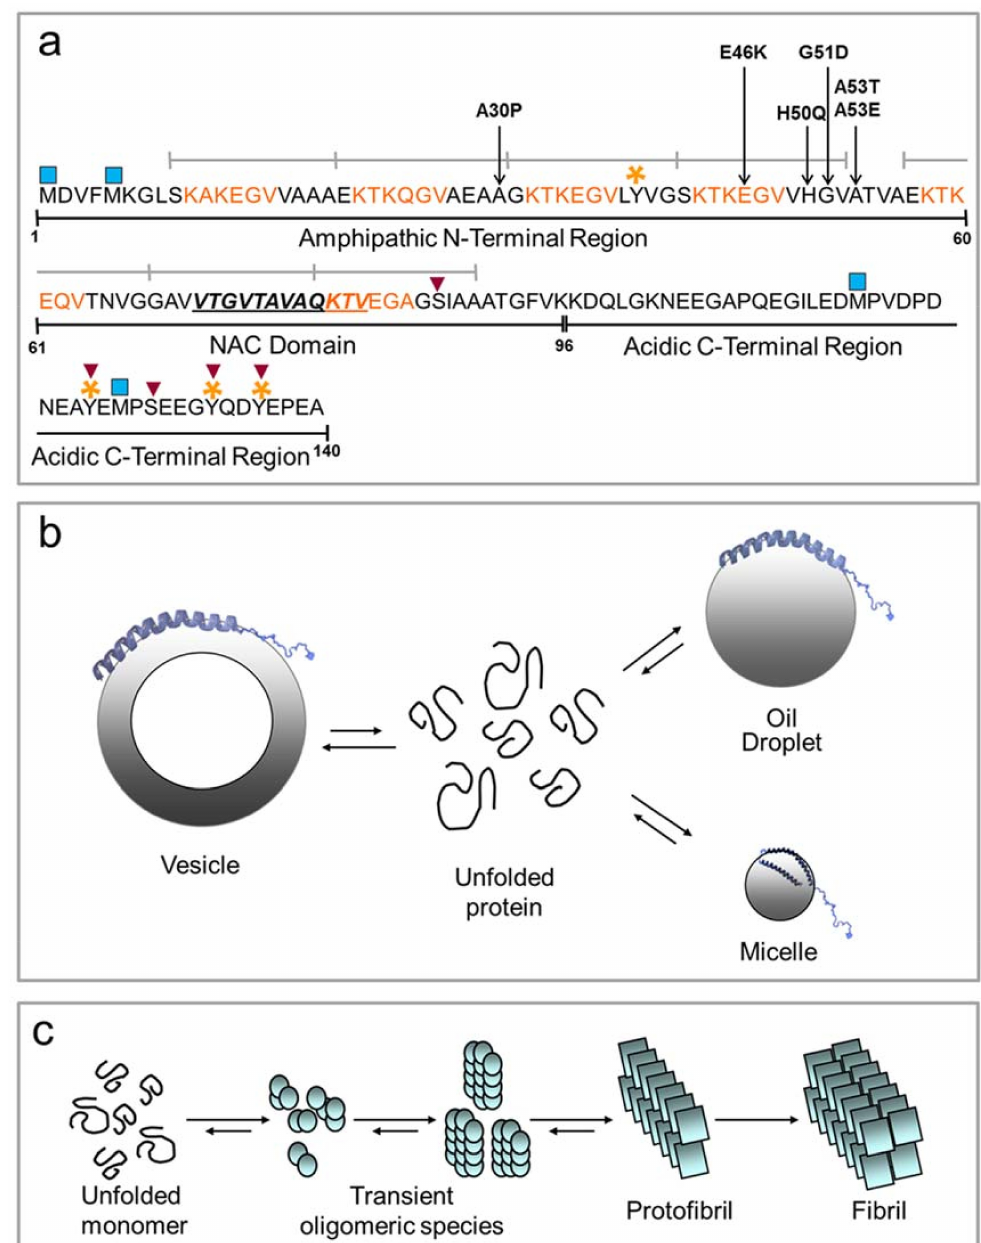
Figure 2. Scheme of the structure of α -syn. ( a ) The three major domains of the protein are indicated: the N-terminal region involved in lipid and membrane binding (1–60), the NAC domain (61–95) responsible for aggregation properties of the protein and the acidic C-terminal region, able to transiently interact with the N-terminal and the NAC domains, modulating the aggregation propensity of the protein (96–140). The 11-amino acid imperfect repeats are indicated by grey lines. The highly conserved amino acid motifs are colored in orange. The 12 residues (71–82) essential for amyloid aggregation are also highlighted. The main pathological missense mutations are located in the N-terminal region. The post-translational modifications are indicated by symbols: blue square, oxidation; red inverse triangle, phosphorylation; orange stars, nitration; ( b ) In the presence of vesicles, micelles and oil droplets, the N-terminal domain of α -syn acquires an α -helical secondary structure. The unbound protein is unfolded (curved lines); ( c ) Schematic mechanism of amyloid aggregation of α -syn. The process is presumably a step-wise formation of larger multimeric protein species, starting from the monomeric unfolded